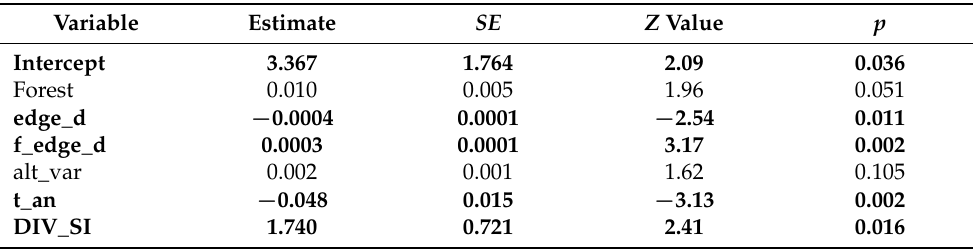
Table 3. General linear mixed model (GLMM, R v.3.1.2) of factors influencing the observed number of common buzzard pairs during the breeding season.